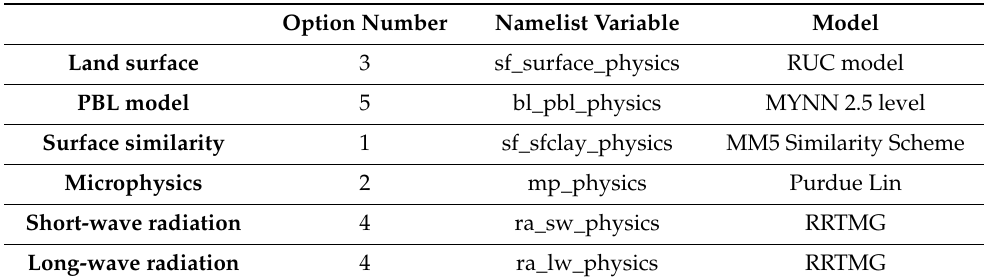
Table 1. List of the variables that constitute the physical parameterization of the WRF–Chem model.